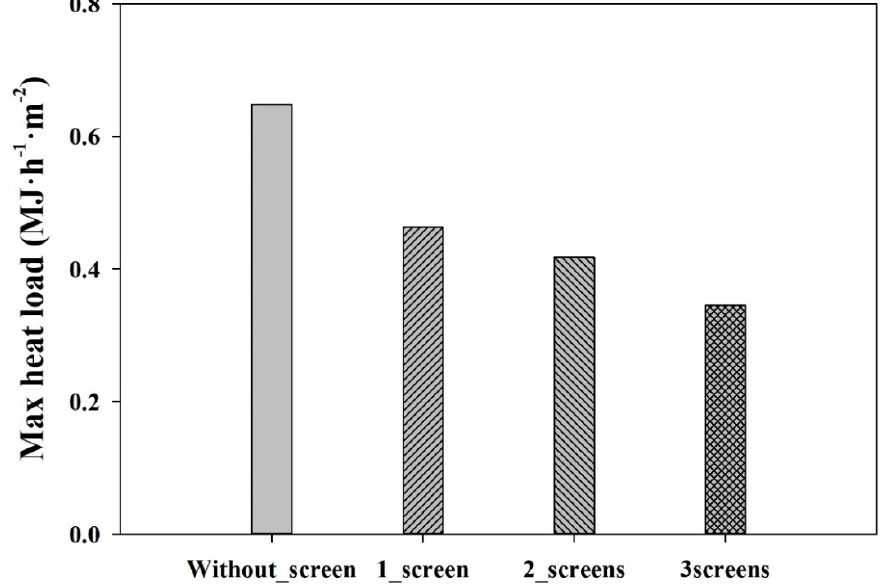
Figure 12. Maximum annual heating load of a greenhouse without a screen and with single, double, and triple screens.